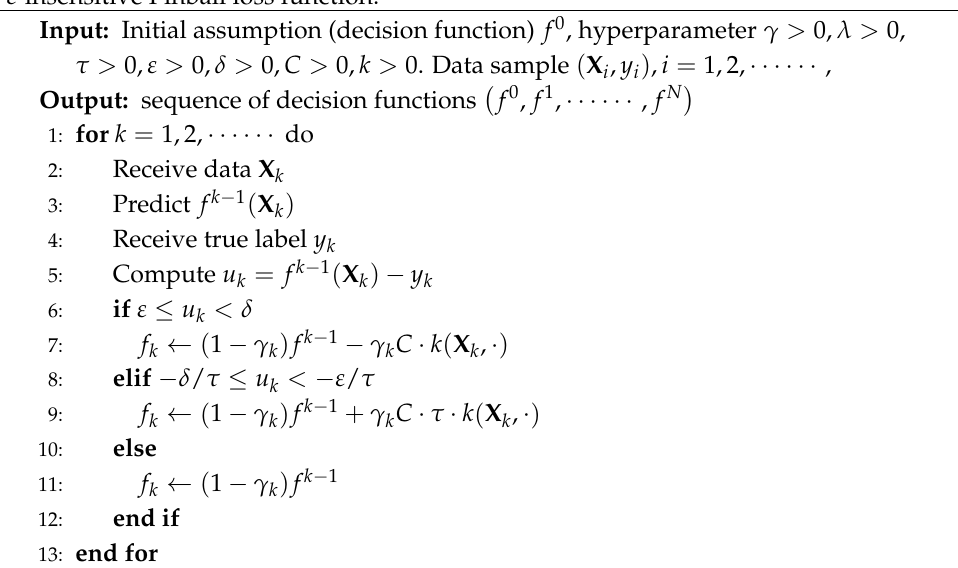
Algorithm 1 details the proposed TIPOSVR algorithm. Algorithm 1: Online support vector regression algorithm based on the truncated ε -insensitive Pinball loss